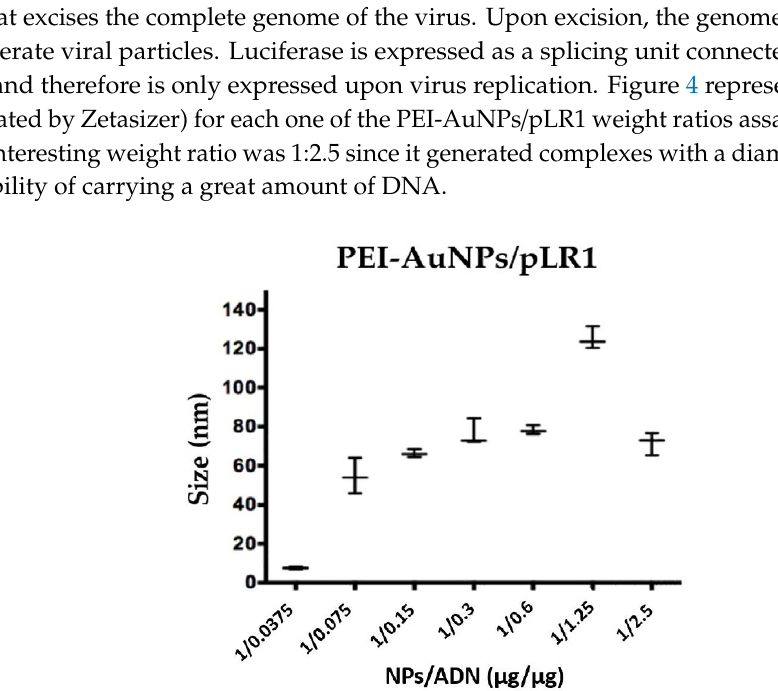
Figure 4. Size of PEI ‐ AuNPs/pLR1. This graph represents the size of the PEI ‐ AuNPs/pLR1 at different weight ratios of PEI ‐ AuNPs and DNA (pLR1) measured by a Zetasizer. The PEI ‐ AuNPs used are NP4 that were synthesized with 8 mg/mL of the initial concentration of PEI.